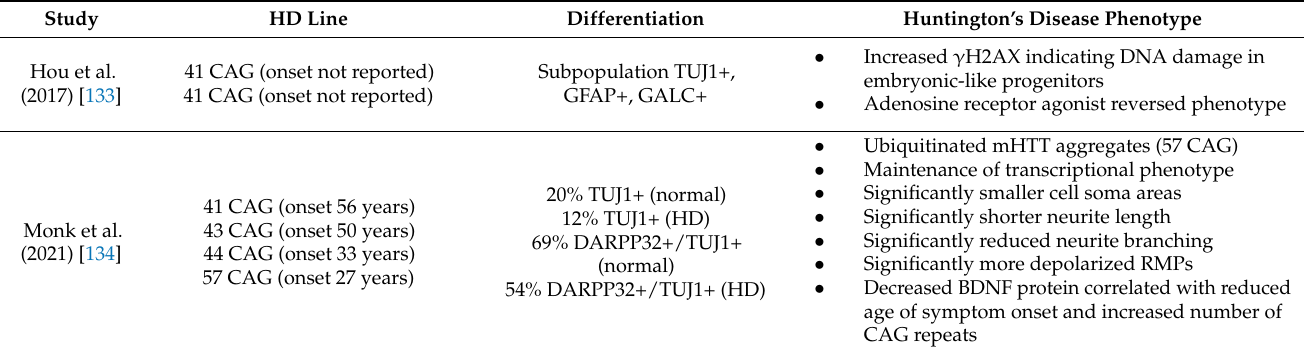
Table 7. Phenotypes observed in Huntington’s disease induced neural precursor cell-derived neurons.